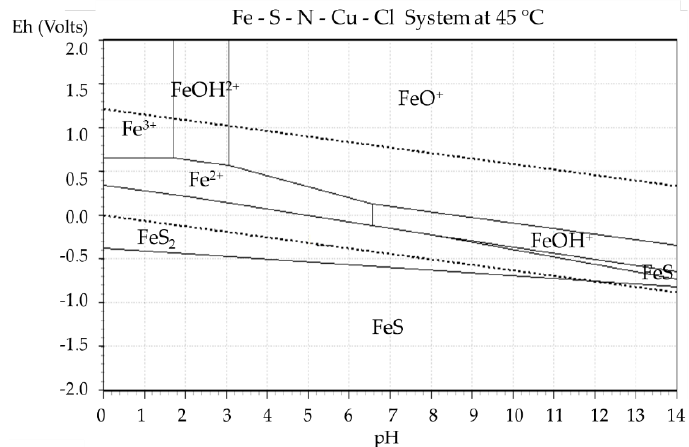
Figure 7. Diagram Eh-pH of Fe-S-N-Cu-Cl at 45 °C, during the interaction of chalcopyrite concentrate (pyrite included) (HSC Chemistry 9.0 version).